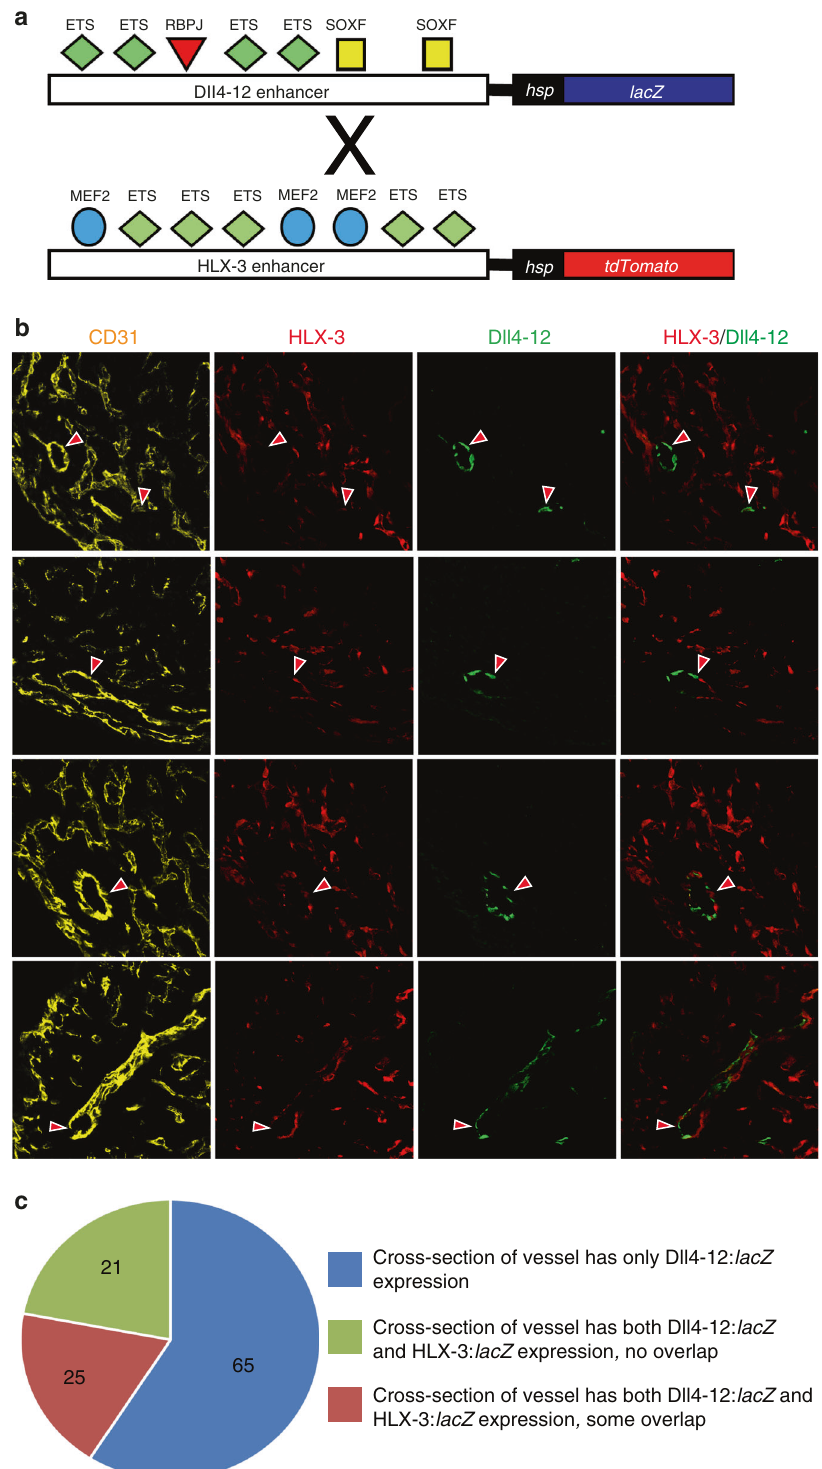
Fig. 6 Direct comparison of HLX-3 and Dll4-12 enhancer activities in coronary vessels at E15.5. a Schematic showing the Dll4-12: lacZ and HLX-3: tdTomato transgenes, with coloured shapes representing veri fi ed transcription factor binding sites. E15.5 hearts were collected from mice transgenic for both transgenes. b Immunostaining showing transgene activity comparative to CD31 staining in the ventricular wall of E15.5 Dll4-12: lacZ ;HLX-3: tdTomato transgenic hearts. Images showing whole heart images from which these are extracted can be seen in Supplementary Fig. 14a. Arterial vessels primarily expressed the Dll4-12:lacZ transgene (green, as detected by anti-ß-gal antibody) but some arterial-located ECs also showed HLX-3:tdTomato activity (red, as detected by anti-tdTomato antibody). c Quanti fi cation of enhancer activity in arterial position Dll4-12: lacZ -positive vessels. Numbers represent number of vessels investigated from four biologically independent E15.5 hearts at multiple levels of heart